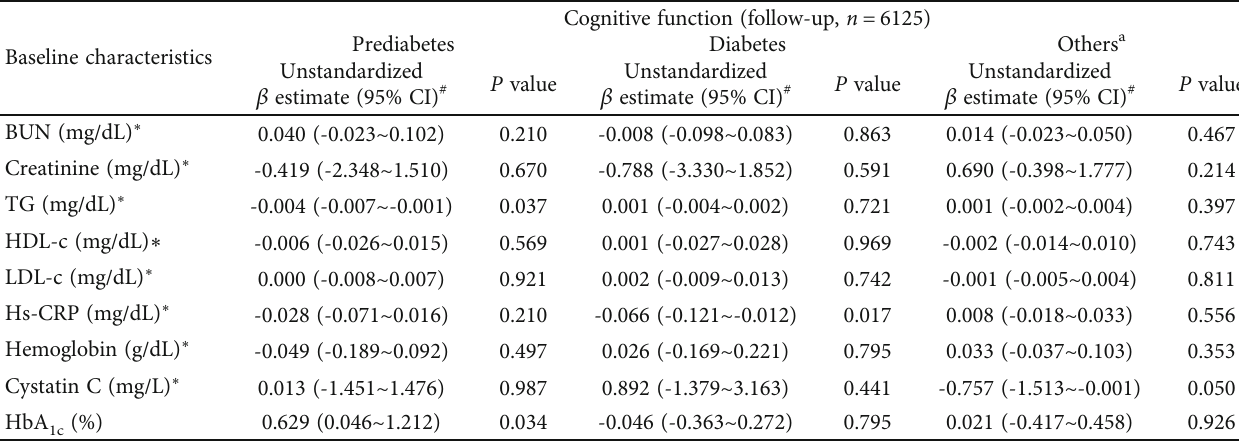
Table 5: Clinical characteristics associated with cognitive function among patients with di ff erent diabetic statuses. Baseline